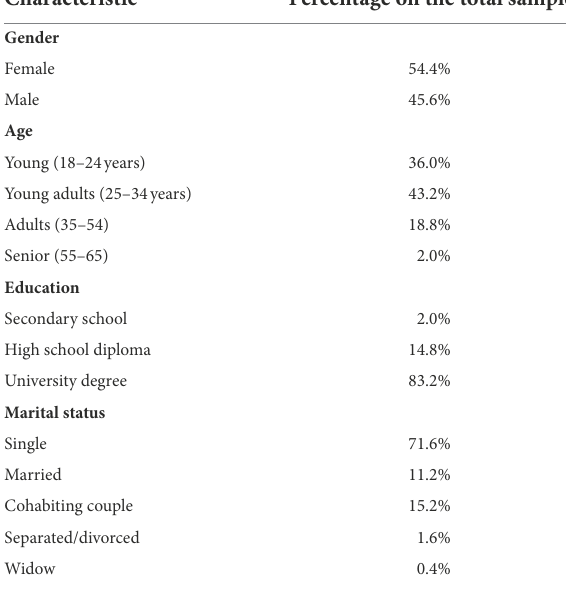
TABLE 2 Demographics of the final study